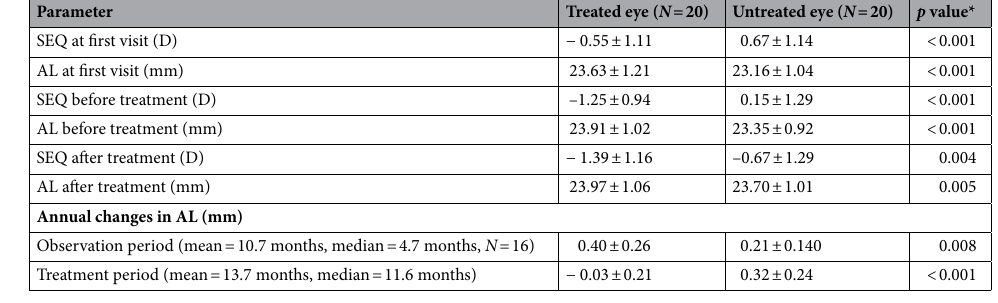
Table 1. Differences in treatment parameters between treated and untreated eyes at the three time points and annual changes in AL during the observation and treatment periods. * p < 0.05, paired t test. Continuous data are expressed as mean ± standard deviation. SEQ, spherical equivalent refractive error; AL, axial length; N , number of